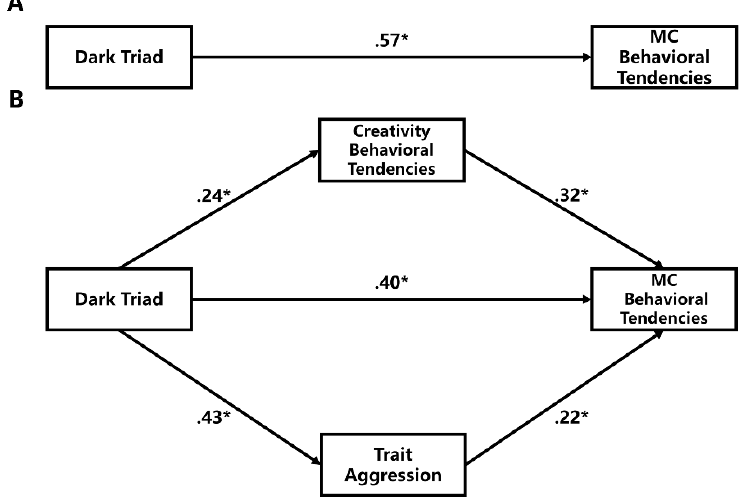
Figure 1. Results of parallel multiple mediation on MCBS: ( A ) the total effect of the Dark Triad on malevolent creativity potential; ( B ) the parallel multiple mediation model. Dark Triad = DD12 score; MC behavioral tendencies = MCBS score; Creativity behavioral tendencies = RIBS score; Trait aggression = BPAQ score; * : p < .05.